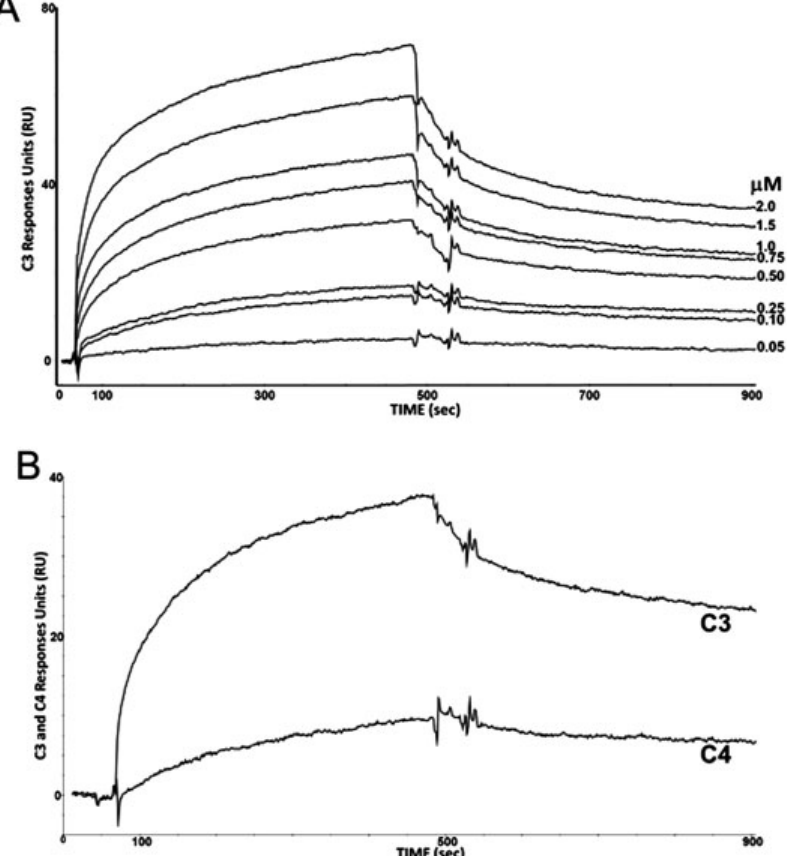
Fig. 4 Analysis of the binding of C3 and C4 to immobilized VWF-A3 domain using surface plasmon resonance. ( A ) A concentration range ( as indicated ) of C3 was analyzed across a recombinant VWF-A3 domain coupled to a biosensor surface at a fl ow rate of 10 μ L/min. C3 bound to VWF A3 domain with a K D of 137 nM. ( B ) Sensorgrams represent the binding of C3 (500 nM) and C4 (500 nM) to immobilized recombinant VWF-A3 domain. The C4 had a K